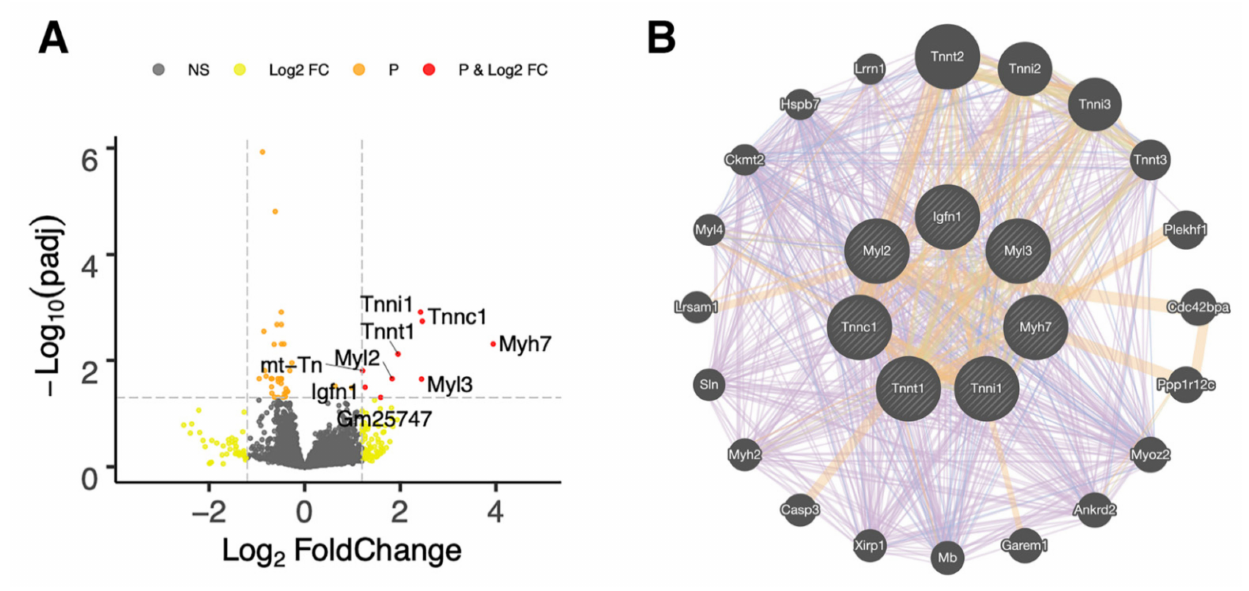
Figure 3. Analysis of merged RNA-Seq data (both sexes PBS vs. rhPRG4) of chondrocytes from male and female Prg4 − / − mice of differentially expressed genes, assorted by their adjusted p (padj) values independent of sex, treated with rhPRG4 compared to PBS. ( A ) Volcano plot of differentially expressed genes, where padj < 0.05 genes are labeled in red. ( B ) GeneMANIA Cytoscape interaction network of genes associated with the significantly upregulated core node genes (cross-hatched circles). Line color depicts gene co-expression (purple), predicted association (orange), and co-localization (blue). Supplementary Tables S2 and S3 illustrate the associated gene identities, which include cytoskeletal and mitochondrial genes, associated with mitochondrial metabolism or associated with mitochondrial DNA. Troponin I1 (Tnni1) has been previously associated with CACP syndrome in humans. Note that mt-Tn and Gm25747 (predicted gene) were not selectable in the GeneMANIA database and thus not incorporated as core node